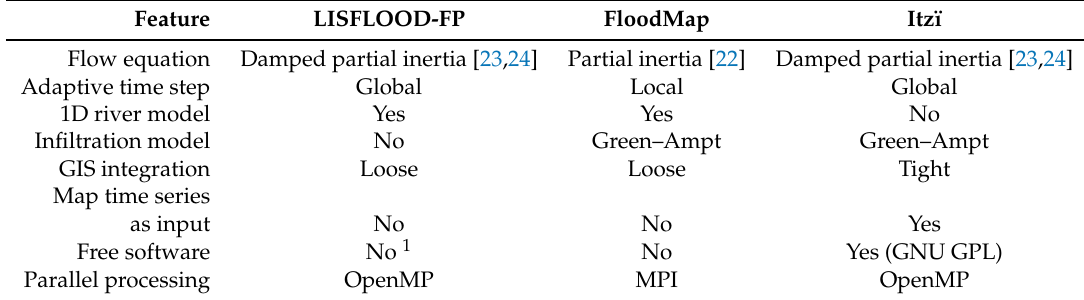
Table 1. Features comparison between LISFLOOD-FP, FloodMap-HydroInundation2D and Itzï.